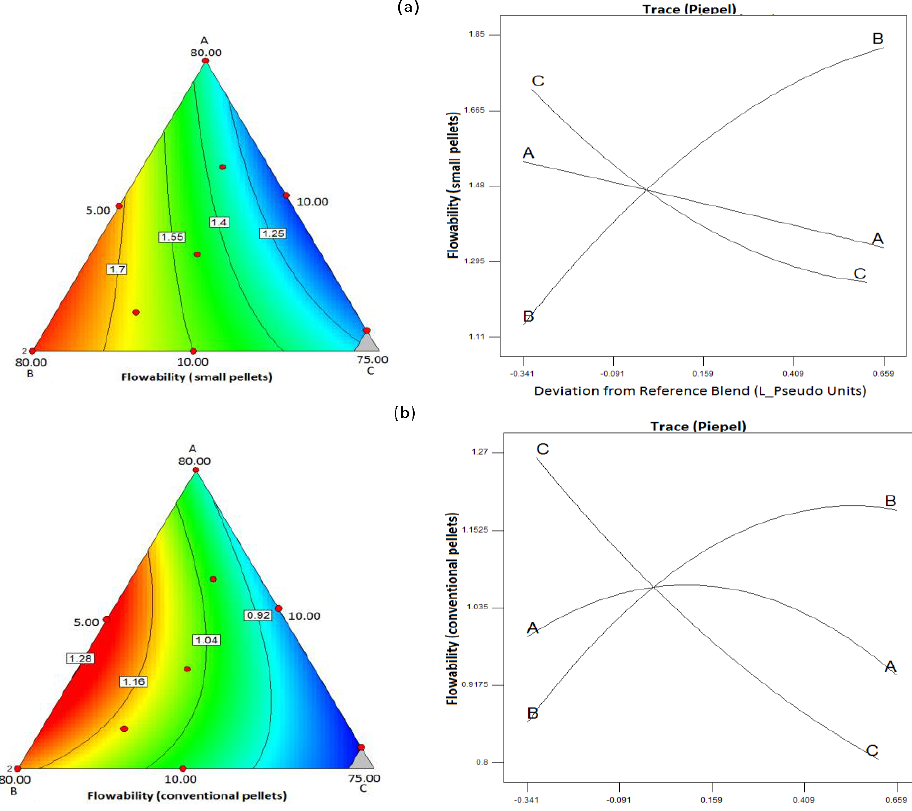
Figure 5. Contour and trace plots of flowability for ( a ) mini and ( b ) conventional pellets.